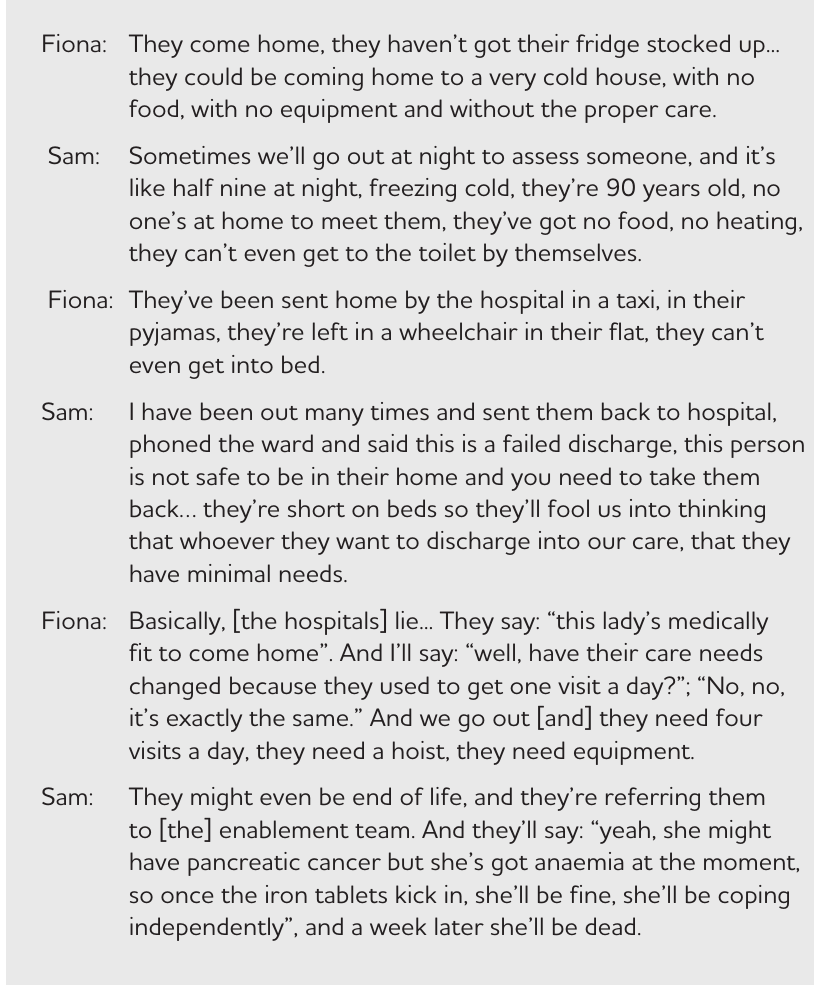
76 The cost of the cuts: the impact on local government and poorer